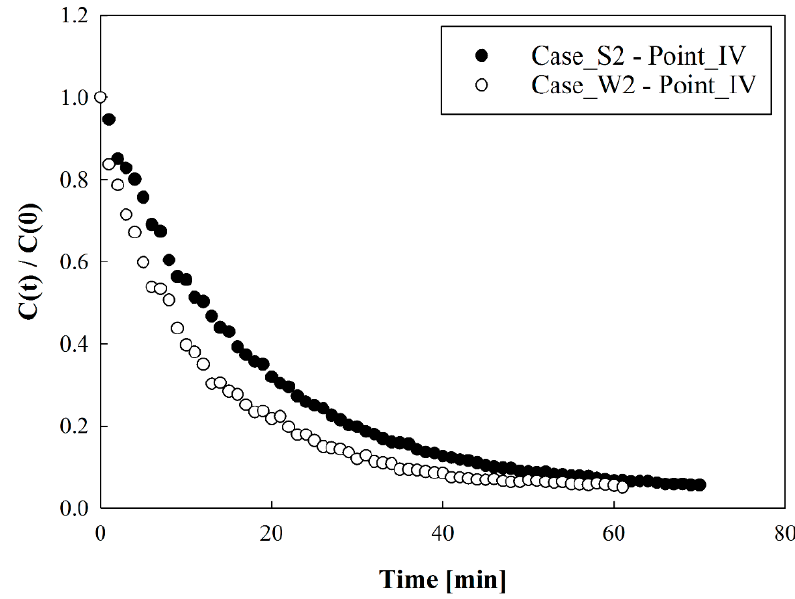
Figure 2. One of the measurement results for particle number concentration over time.